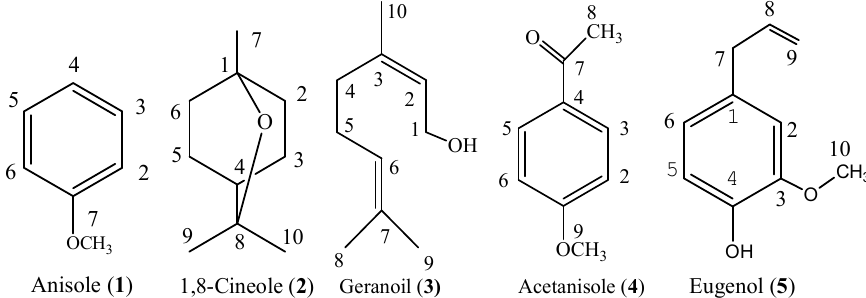
Figure 1. Constituent compounds isolated from the essential oil of Stachys riederi var. japonica aerial parts.